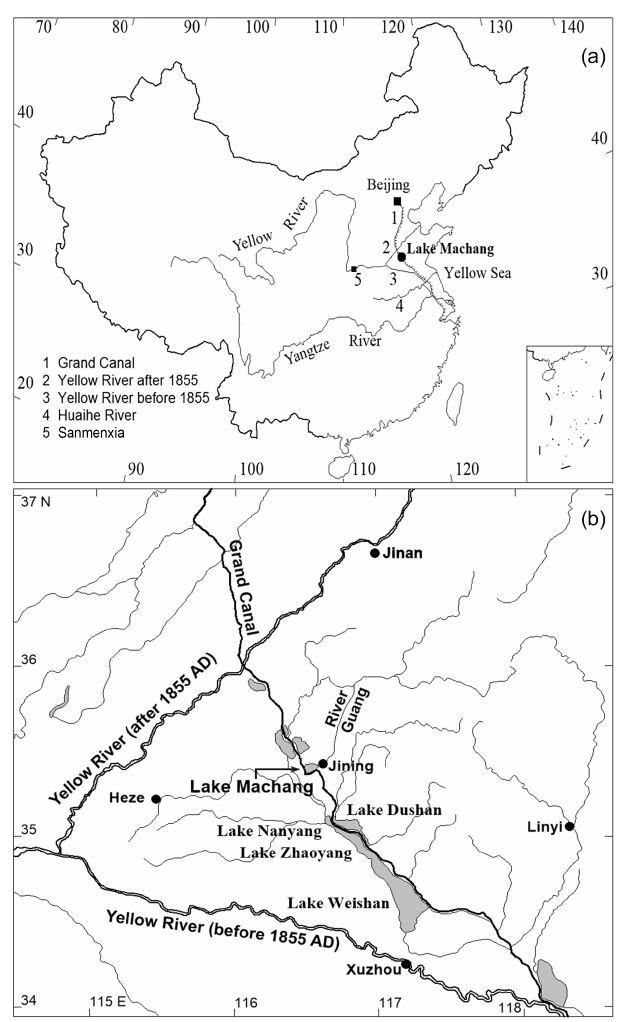
Figure 1. Maps showing the location (a) and vicinity (b) of Lake